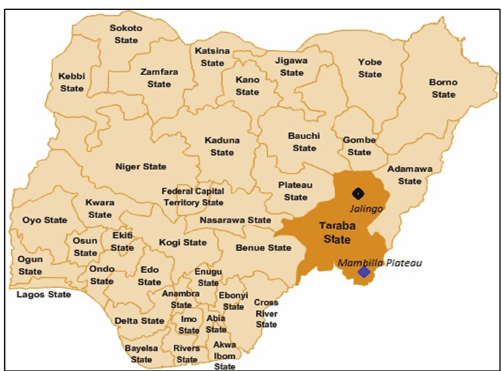
Figure 1: Map showing the study location in Taraba State, North Eastern Nigeria.